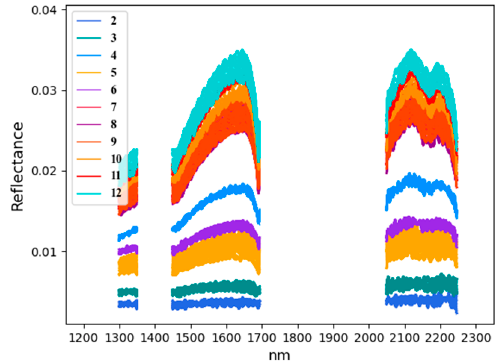
Figure 10. Generated spectral feature data curves.